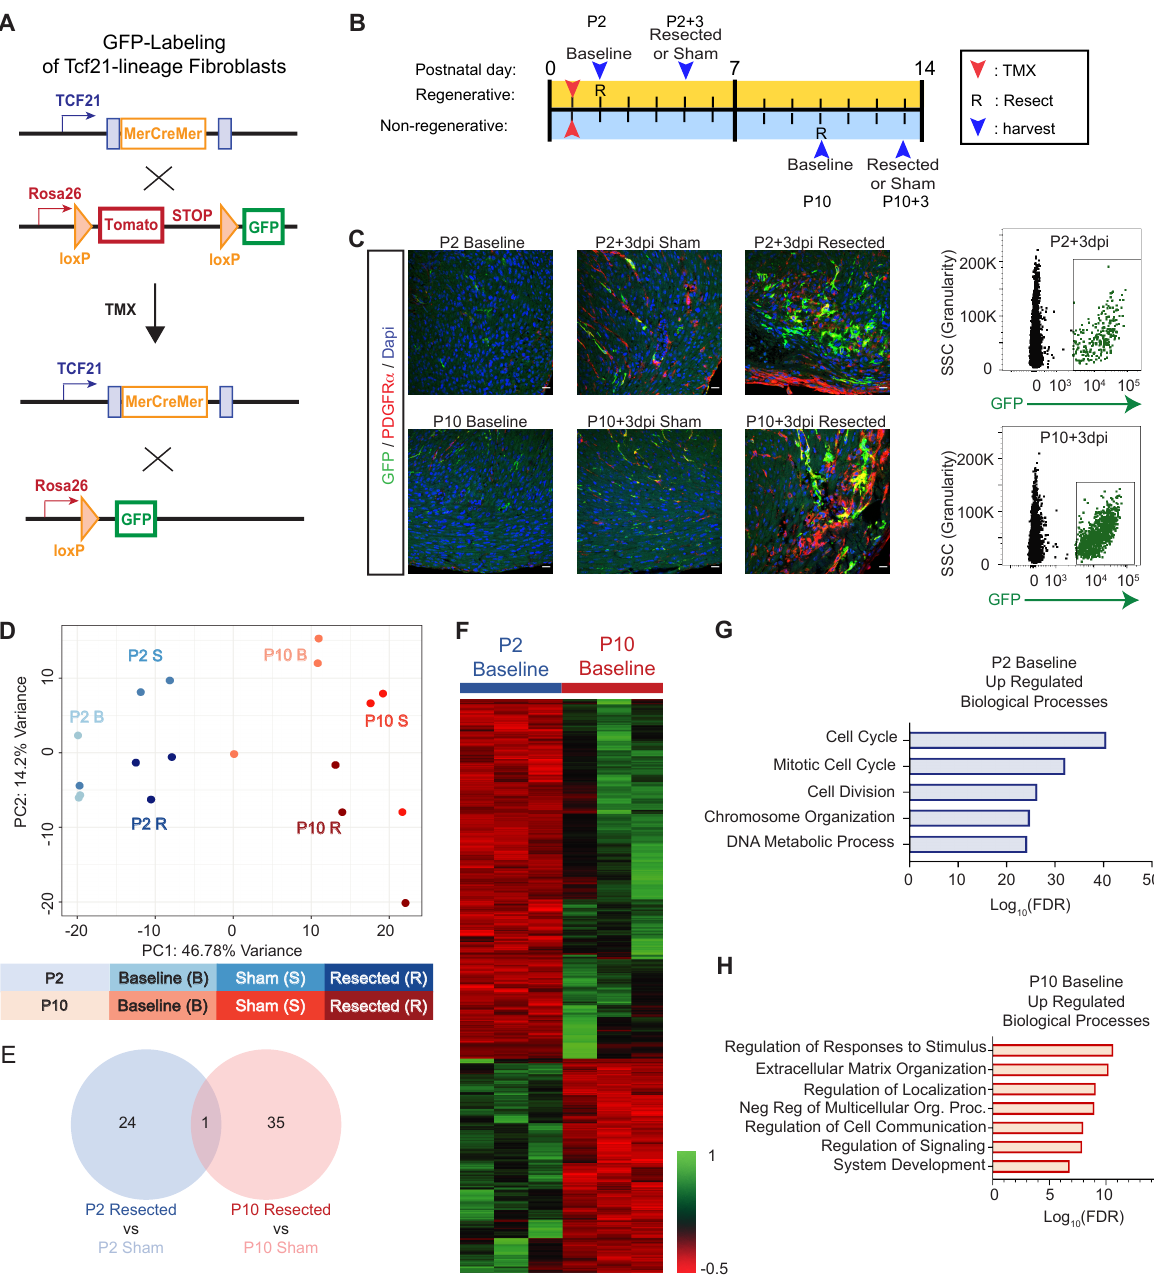
Figure 1. RNA sequencing of resident cardiac fibroblasts reveals a switch to secretory phenotype which corresponds to loss of regenerative capacity. ( A ) Schematic describing the breeding strategy used to generate mice that allowed fluorescent lineage training of resident fibroblasts. ( B ) Schematic describing experimental strategy, including timing of tamoxifen (TMX) injections, apical resection or sham surgeries (R), and fibroblast and tissue isolations. ( C ) Hearts were obtained from